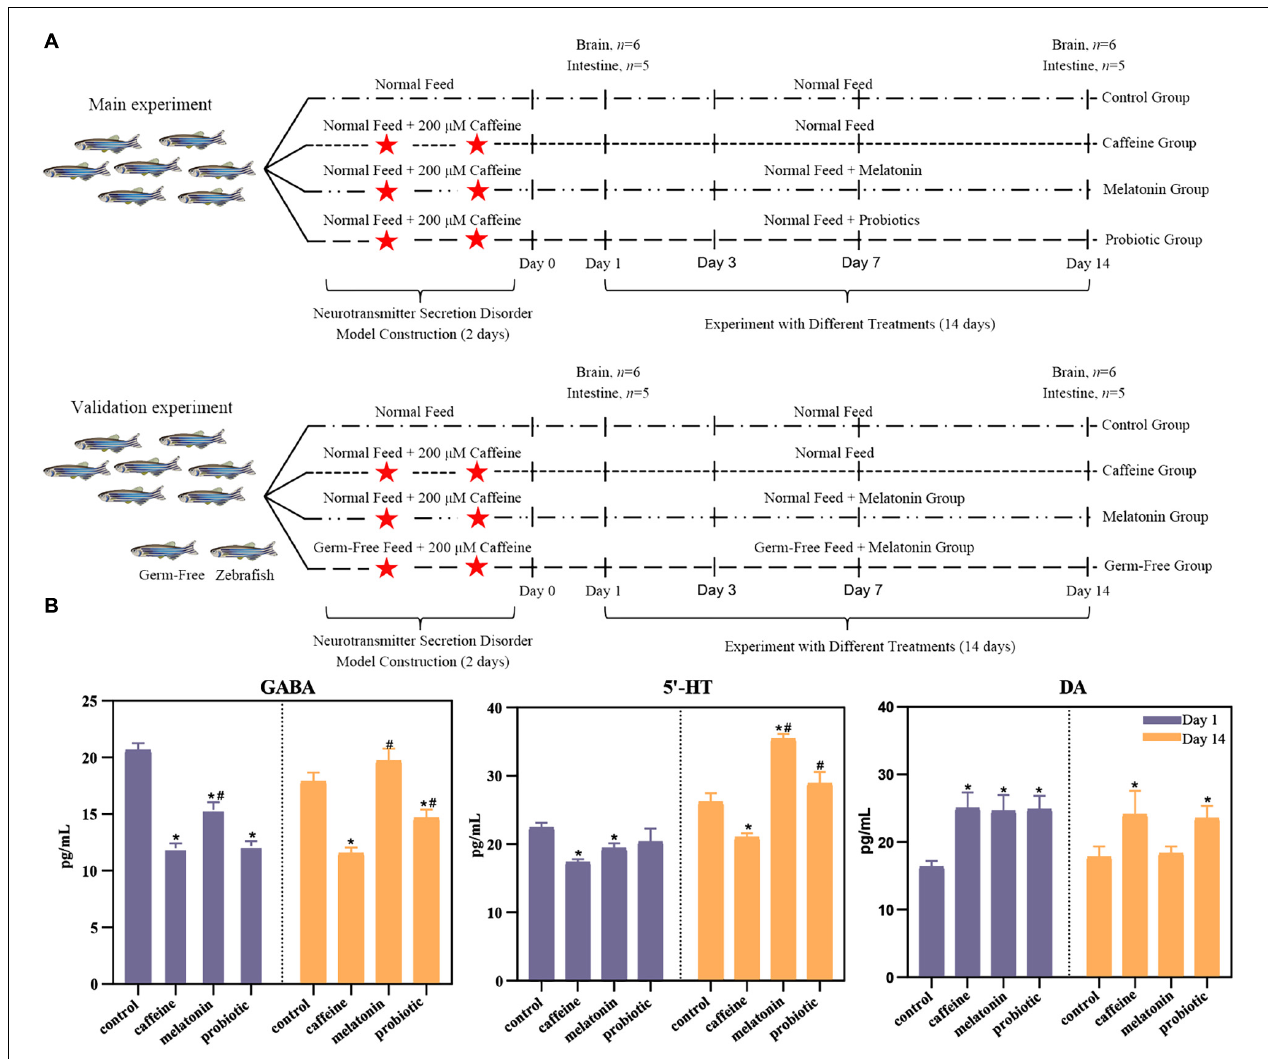
FIGURE 1 | Experimental design and the effects of neural hyperactivity on the levels of neurotransmitters (DA, γ -GABA, and 5-HT) in the zebrafish brain. (A) Experimental design. In the main experiment, the fish were divided into four groups. The control group was treated with normal feed and regular filtered water throughout the experiment. The caffeine, melatonin, and probiotic groups were subjected to two consecutive days of caffeine exposure and then maintained under the corresponding conditions (caffeine group: normal feed + regular filtered water, melatonin group: normal feed + filtered water with 1 µ M melatonin, probiotic group: feed containing 8.0 log10 Lactobacillus plantarum HNU082/g of feed + regular filtered water). On days 1 and 14 after caffeine induction, the brain and intestine of each zebrafish were collected for neurotransmitter level determination and high-throughput sequencing, respectively. For the verification experiment, the study added the GF zebrafish groups, and the experimental design and feed conditions were the same as the main experiment. (B) Effects of neural hyperactivity on the levels of neurotransmitters (DA, γ -GABA, 5-HT) in the zebrafish brain; the variation in the secretion levels of neurotransmitters in response to melatonin and probiotic supplementation were determined by ELISA. Mann-Whitney test was used to assess the differences in neurotransmitter levels in the zebrafish brain on days 1 and 14. * p < 0.05 compared with the control group. # p < 0.05 compared with the caffeine